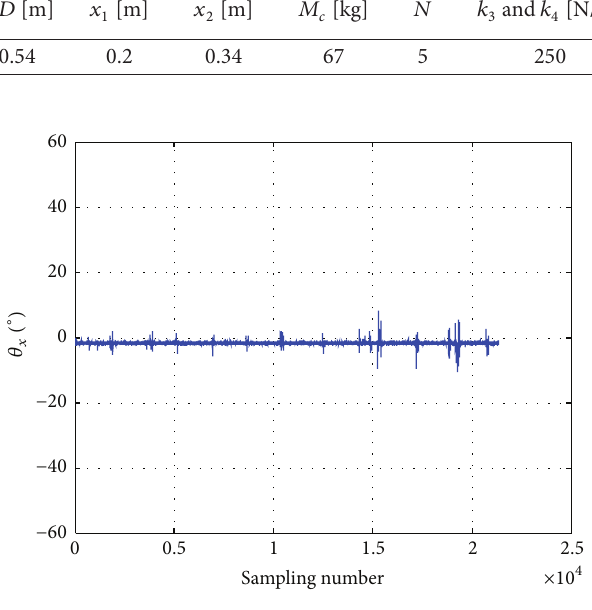
Figure 7: 𝜃 𝑥 for controlled system.